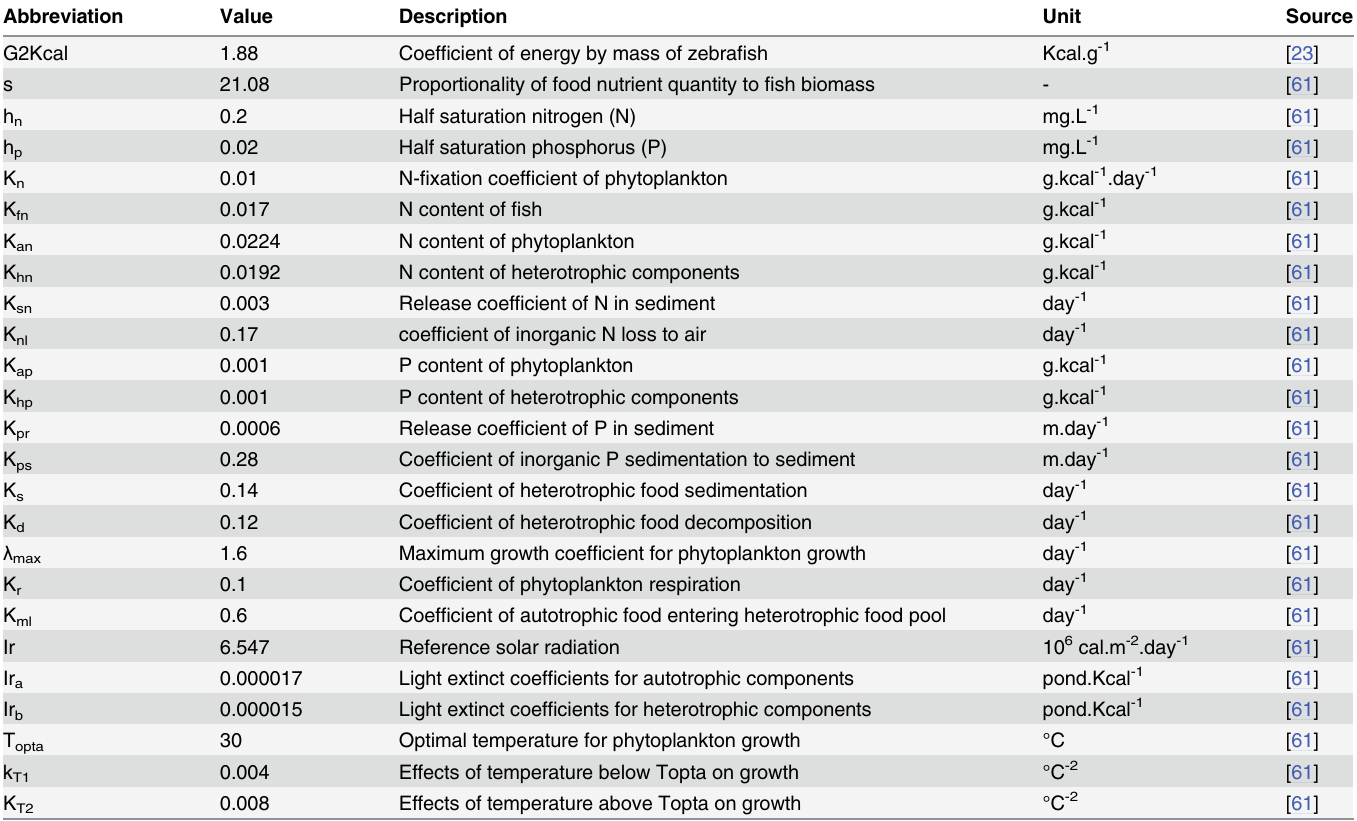
Table 2. Parameter abbreviations, values, descriptions and units of the food